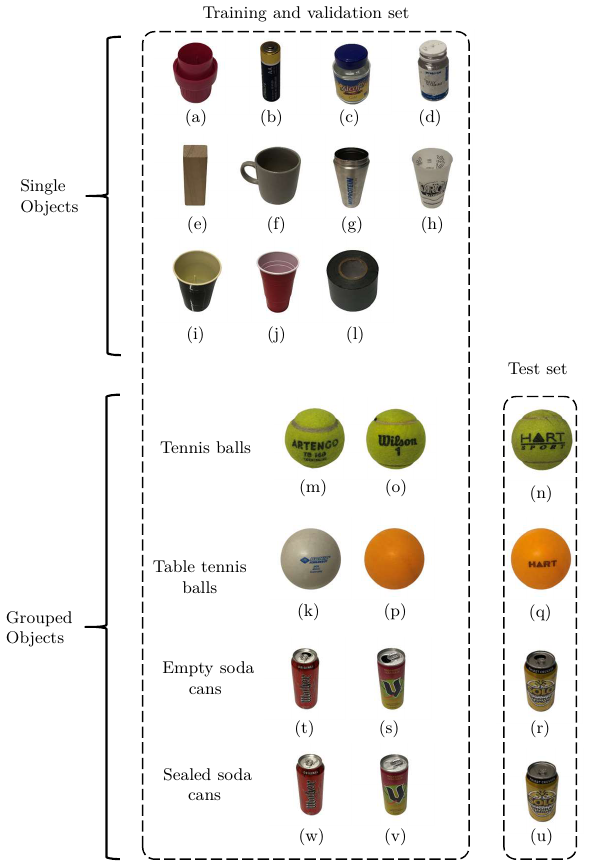
Figure 9. The 23 objects labelled as single objects or grouped objects. Here, there are four groups of objects, tennis balls, table tennis balls and either full or empty soda cans. Each object in this represents 864